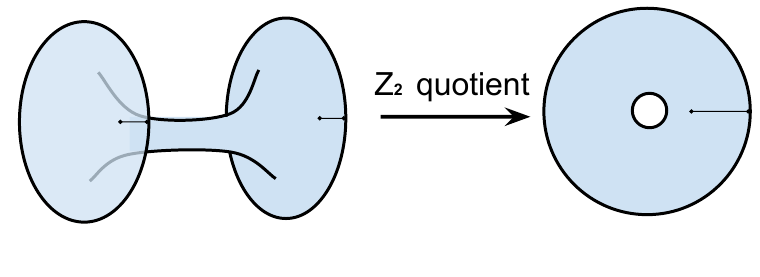
Figure 4. The n -replica geometry M n with a possible replica wormhole (left), and the Z n quotient geometry M n =Z n . The quotient geometry has no conical singularity at the boundary of A , but has a conical singularity with angle 2 (cid:25) at the boundary of the extra branching surface (i.e. the \island") I n